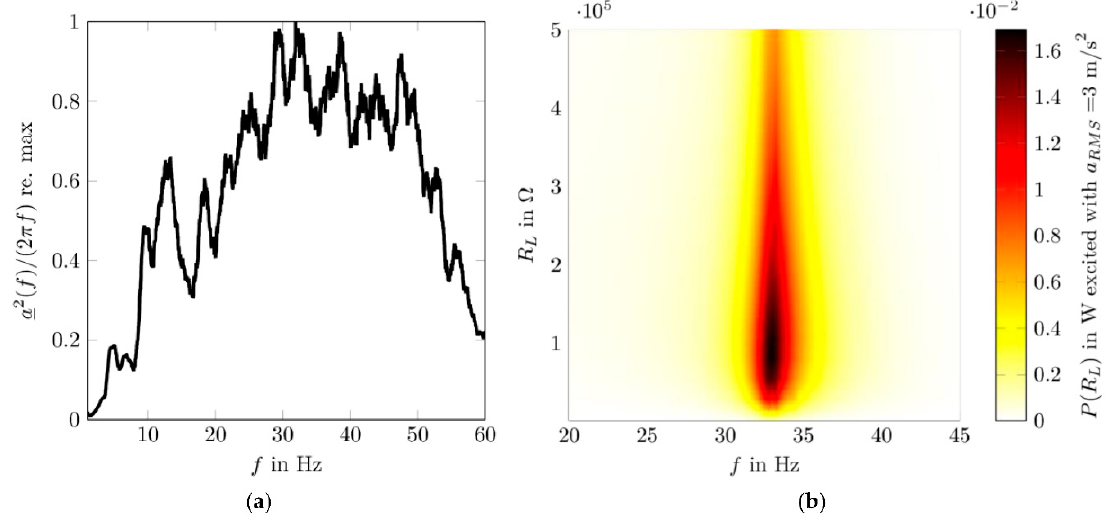
Figure 2. ( a ) Power spectrum of measured acceleration. ( b ) Electrical power output ((cid:1844) (cid:1838) ) of the piezoelectric energy harvester at directly connected load resistance (cid:1844) (cid:1838) with harmonic excitation frequency (cid:1858)